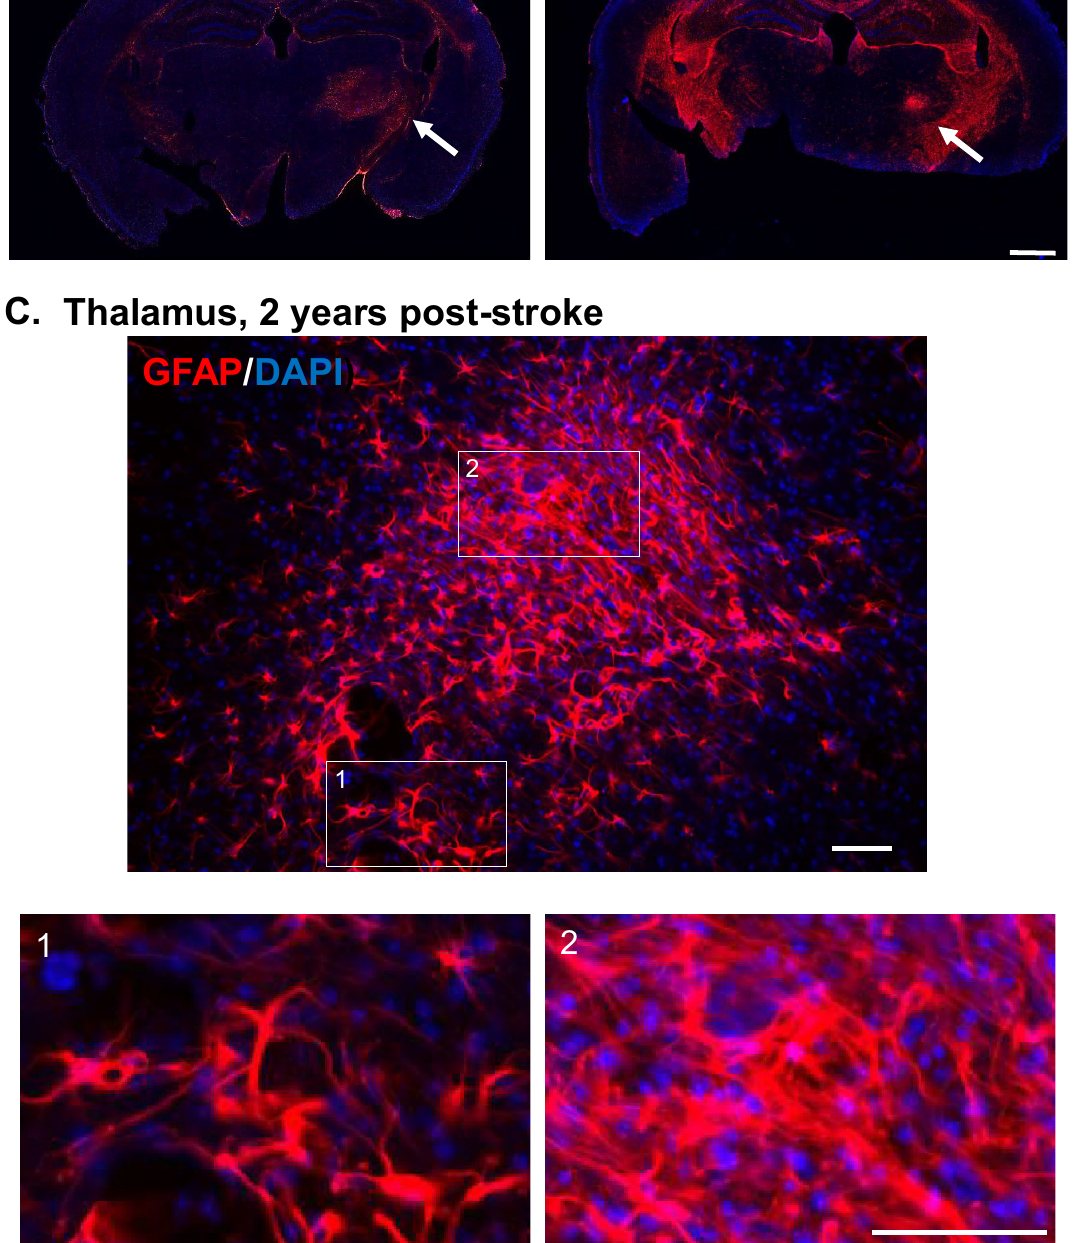
Figure 7. Astrogliosis in ipsilateral thalamus is long-lasting and can eventually develop glial scar-like characteristics. Young mice were subjected to dMCAO and then allowed to recover for 6 weeks or two years. At 6 weeks or two years post-stroke, brains were evaluated for astrogliosis (GFAP). Brain sections showing astrogliosis at 6 weeks ( A ) or two years following stroke ( B ) (10X, stitched image; scale bar = 1 mm). ( C ) Enlarged region of thalamus from two year post-stroke brain showing glial scar-like characteristics (40X obj; scale bar = 50 µm). Two regions (1 and 2) were further enlarged to show different regions of